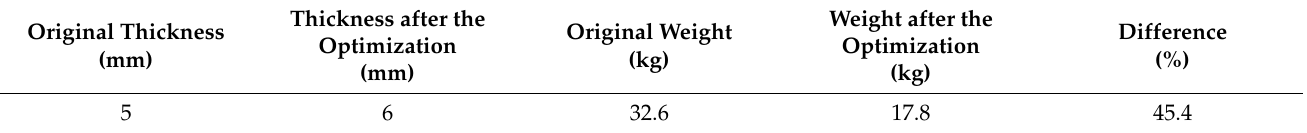
Table 8. Comparison of the thicknesses and weights of the frame parts using the steel of the